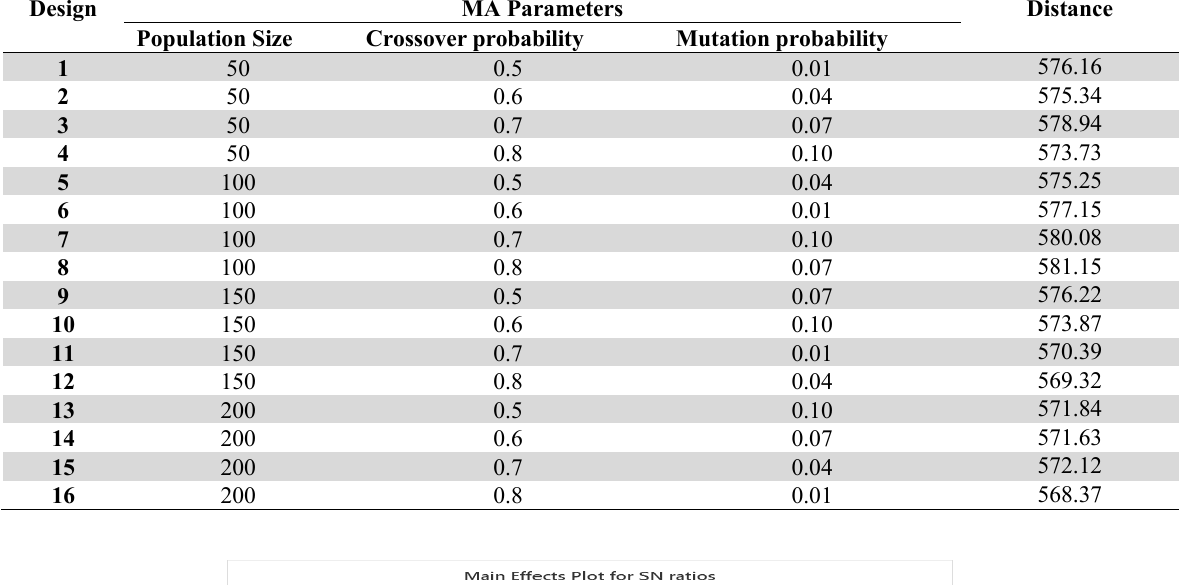
Results obtained from different designs of Taguchi method